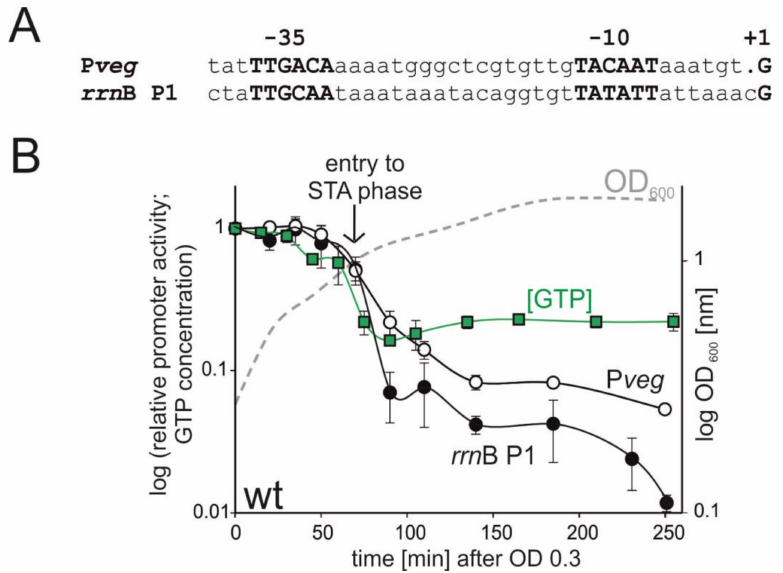
Figure 1. Correlation between GTP concentration and promoter activity after entry into the stationary phase. ( A ) Sequences of P veg and rrn B P1. ( B ) Relative promoter activities of rrn B P1 (black circles) and P veg promoters (open circles) after entry into stationary phase, relative GTP concentration (green squares), and optical density (dashed grey line). Promoter activities and GTP concentrations were normalized to 1 at time 0. Promoter activities were measured by qPE from wt B. subtilis strains: rrn B P1 (LK134), P veg (LK135). Promoter activities were calculated from three independent experiments, the error bars show ± SD. The GTP concentrations are from two independent experiments, showing the mean, the bars show the range. A representative bacterial growth curve is shown. The vertical arrow indicates the entry into stationary